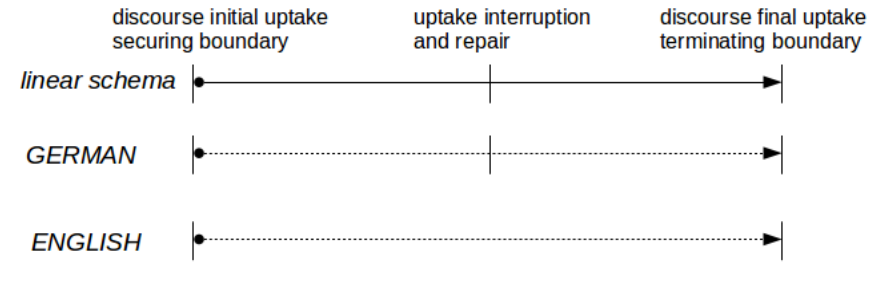
Figure 3: Linear schema for uptake establishing, repair and termination with chanted intonation